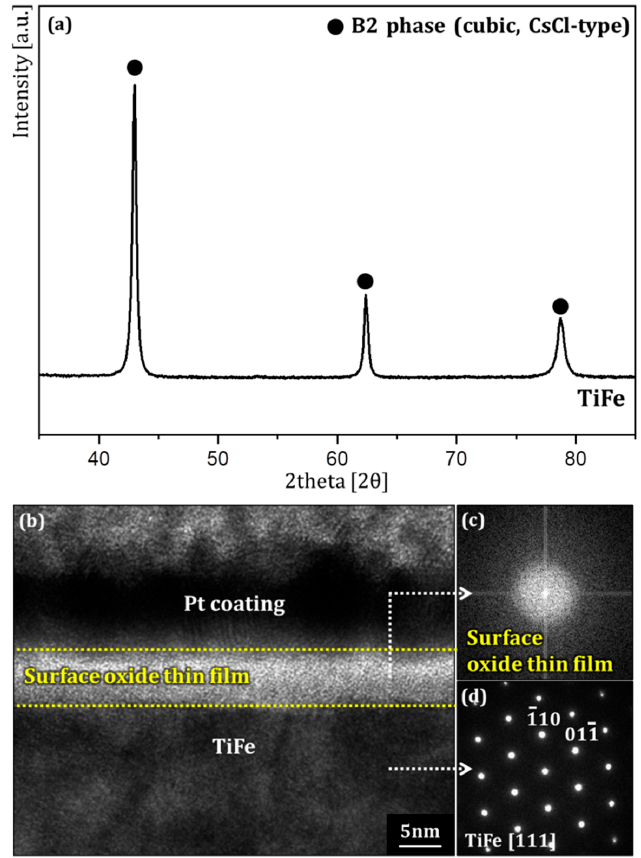
Figure 1. Structural characterization of the as-cast TiFe alloy obtained by X-ray diffraction (XRD) ( a ), cross-sectional transmission electron microscopy (TEM) ( b ), and selected area diffraction patterns (SADPs) of both the thin surface oxide film ( c ) and the TiFe bulk ( d ). Thermodynamic differences between Ti and Fe, in terms of the surface Gibbs free